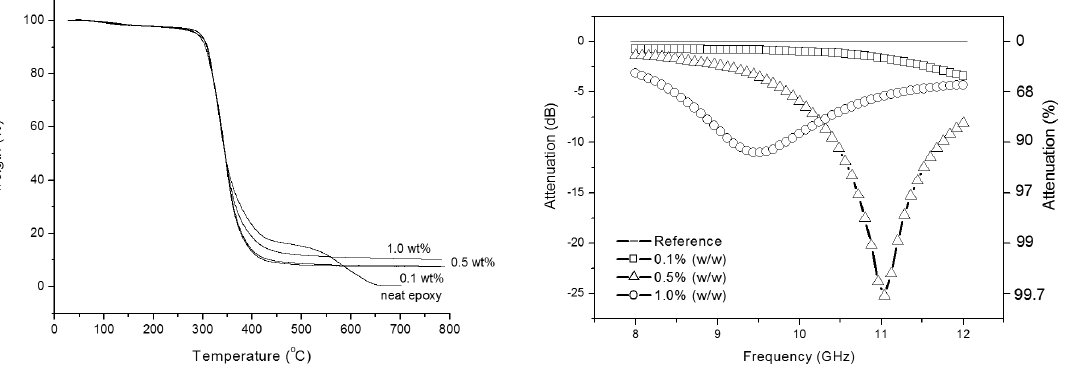
Figure 7. TGA curves of neat epoxy and nanostructured composites CNT/epoxy.